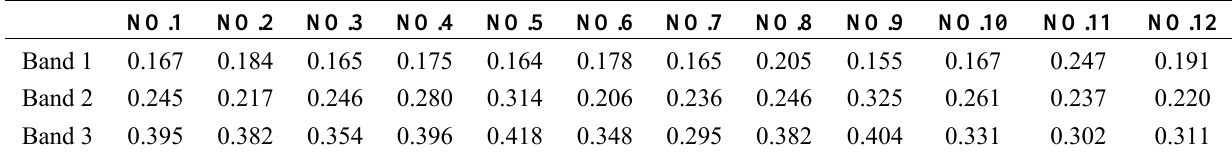
Table 2. The fractal features of one set of crack